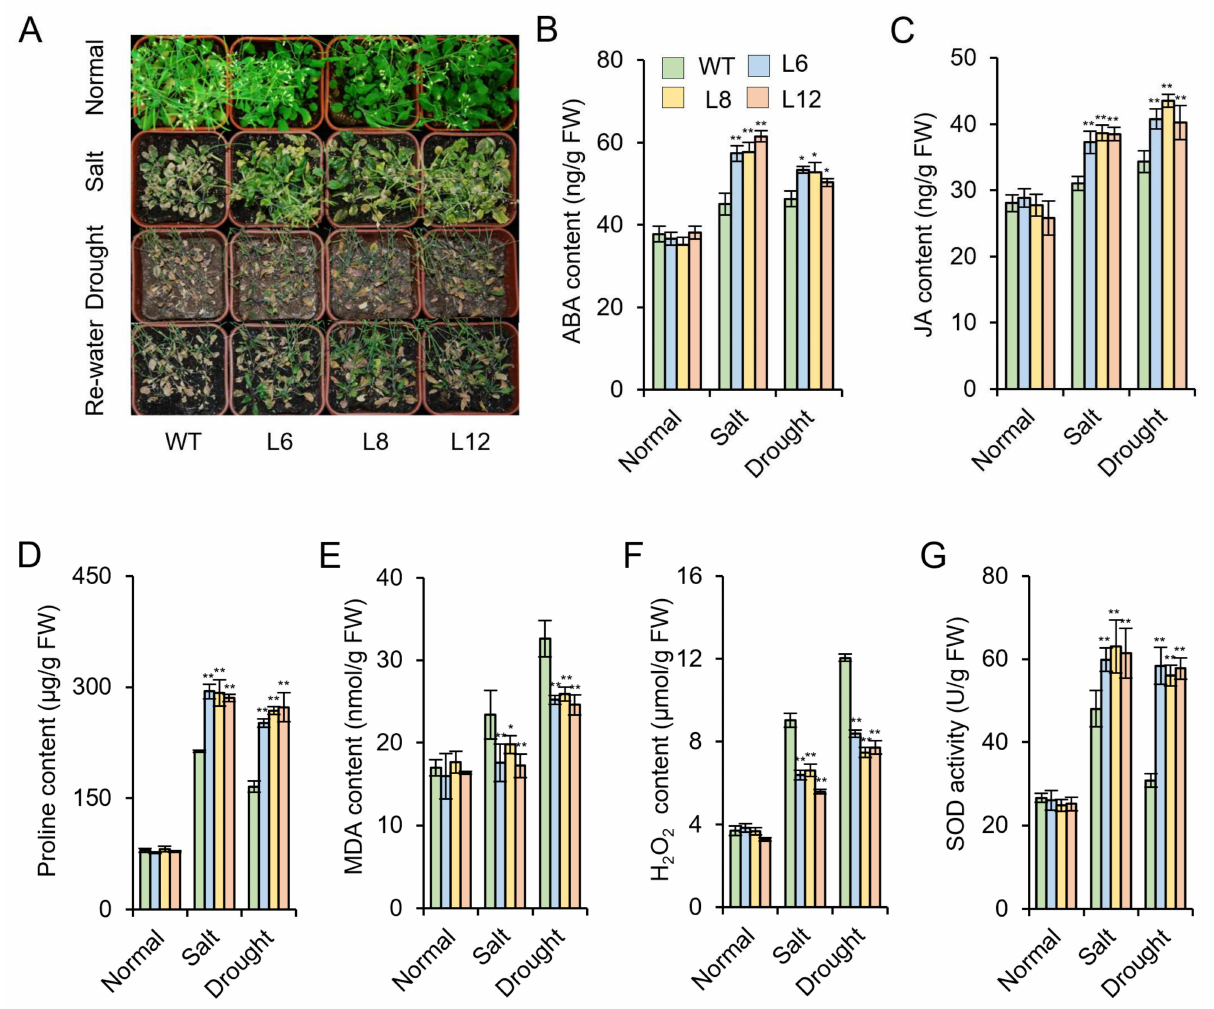
Figure 7. Responses of transgenic lines and WT grown in pots under salt and drought stresses. ( A ) The transgenic lines and WT grown in 1/2 Hoagland solution with 300 mM NaCl. Performance of transgenic lines and WT treated with soil drought stress without water for 3 weeks and then recovered for 2 days. Bar = 2 cm. ( B – G ) ABA ( B ), JA ( C ), proline ( D ), MDA ( E ), and H 2 O 2 ( F ) contents and SOD activity ( G ) in the transgenic Arabidopsis plants and WT under salt and drought stress. Values are shown as mean ± SE ( n = 3); Asterisk (*) and (**) indicate that there is a significant difference at p < 0.05 and p < 0.01,